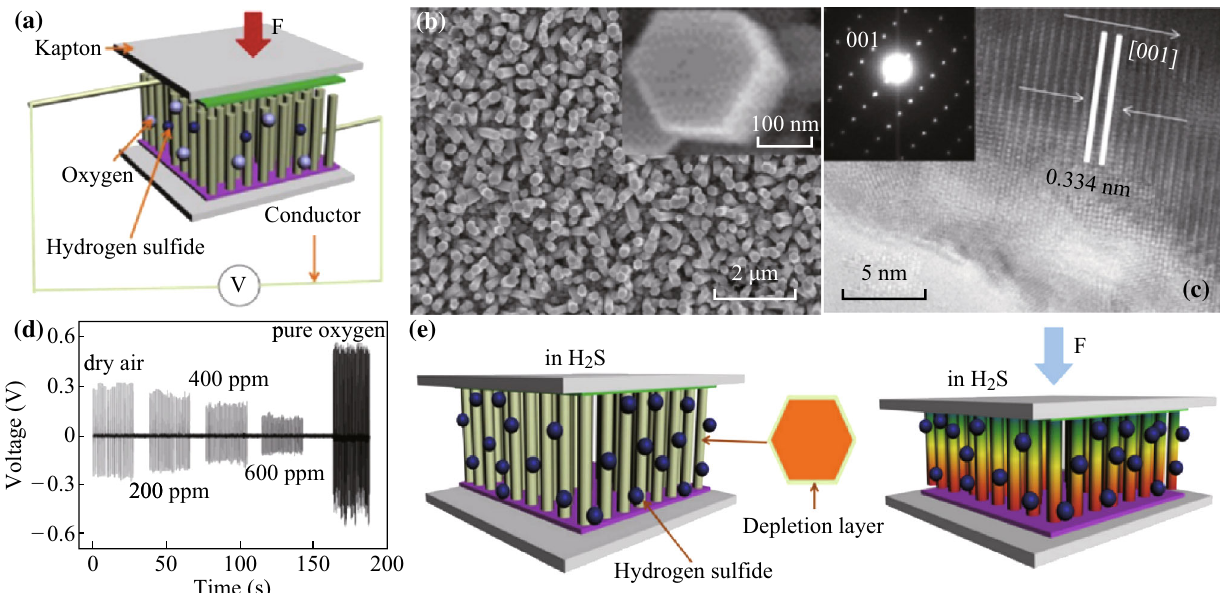
Fig. 6 Synthesis of CdS nanorod arrays and their applications in flexible piezo-driven active H 2 S sensors. a Schematic diagram showing the structural design of the piezo-driven active H 2 S sensor based on CdS nanorod arrays. b SEM image of CdS NR arrays grown on Ti foil in a top view (the inset is an enlarged view of a selected area). c HRTEM and SAED pattern of the tip region of a CdS nanorod. d The piezoelectric voltage response of a device in dry air, H 2 S and pure oxygen at room temperature. The working mechanism of a CdS piezo-driven active H 2 S sensor. e The carrier density and depletion layer in CdS nanorods in H 2 S without compression and piezoelectric output under mechanical deformation. Figures adapted from